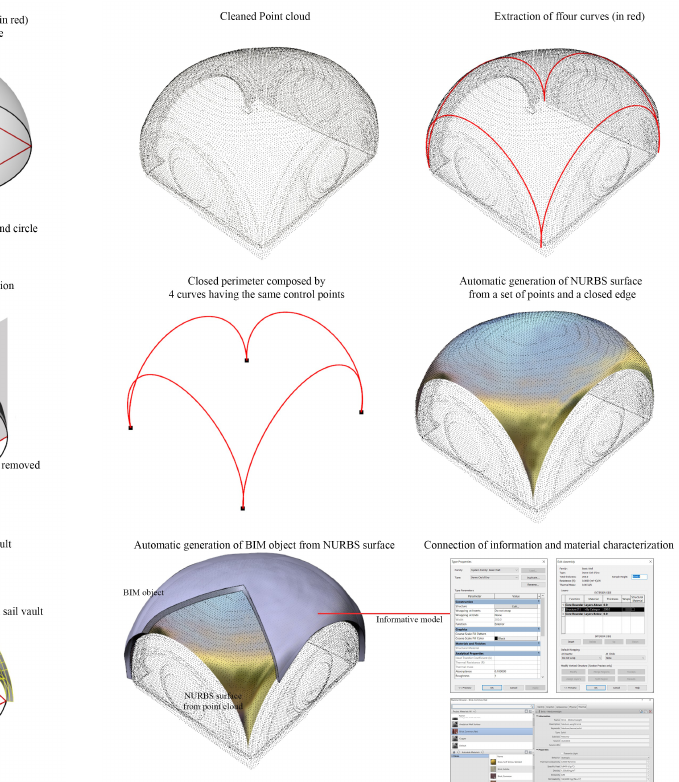
Figure 10. The traditional process: ‘how to model a sail vault’. The traditional process requires a great number of modelling steps based on simplified geometric primitives. Each step is not oriented to intercept the real shape of the point clouds characterised by geometric irregularities.